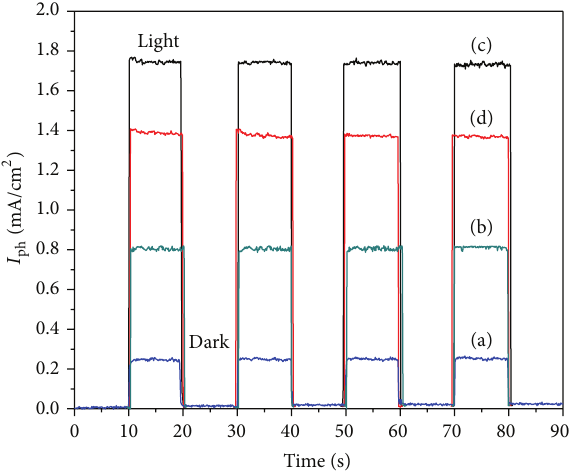
Figure 9: Comparison of photoluminescence spectra of the as- nitride, (b) CdS/CN-5, (c) CdS/CN-10, (d)